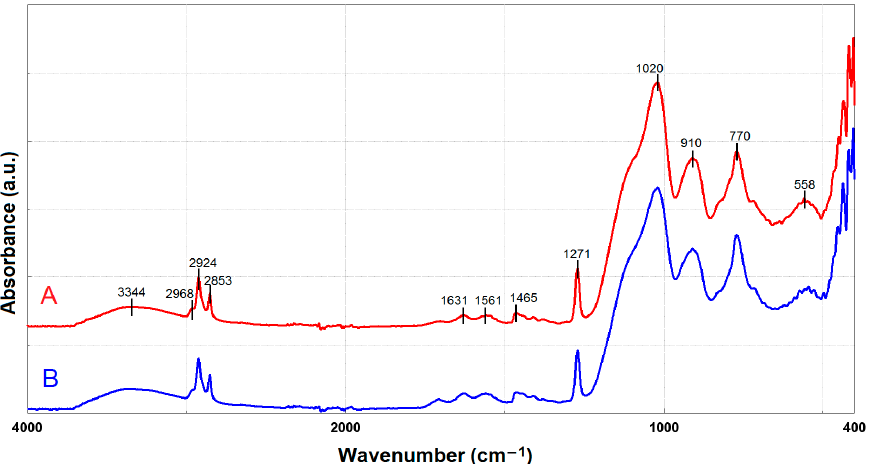
Figure 2. FTIR–ATR spectra of silica material (sample A) and of silver-based silica material (sam- ple B), obtained as powders.